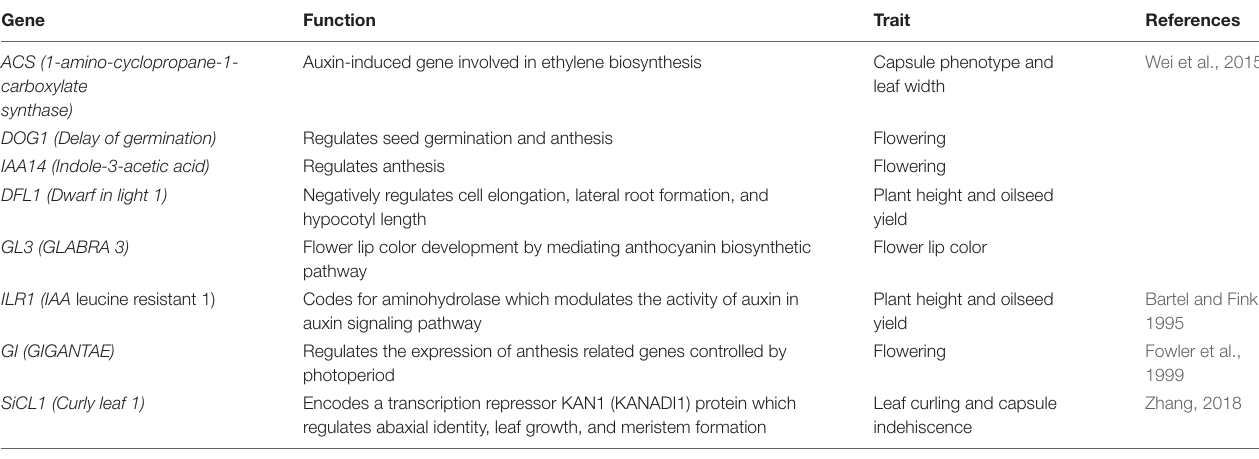
TABLE 4 | Genes related to morphological traits in sesame.